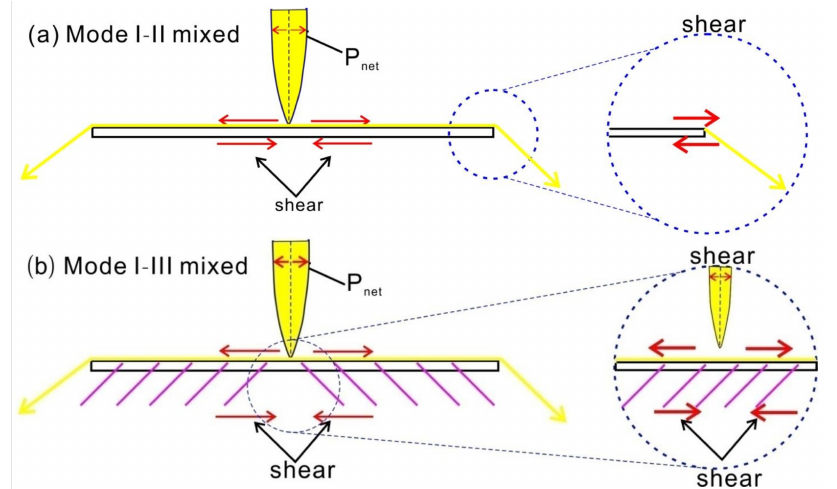
Figure 10. Sketches of the mixed I-II and mixed I-III modes for the fractured model blocks (revised from the literature of [14]). The red arrows show shear on the natural fracture surface due to the opening